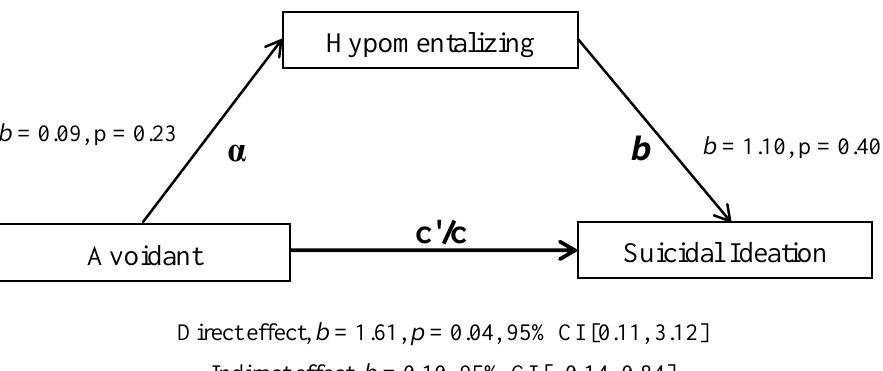
Figure 1. Mediation model with avoidant attachment as the independent variable, hypomentalising as mediator and suicidal ideation score as dependent variable. Controlling for age, gender and current depression.